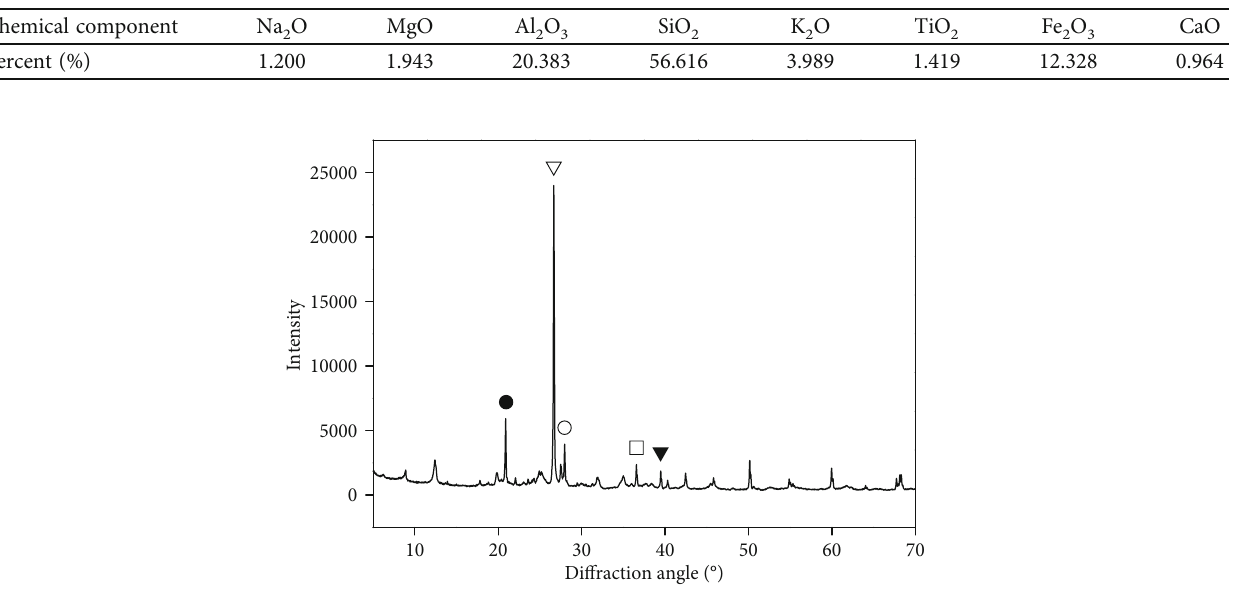
Table 1: The chemical composition of mudstone in coal mine.